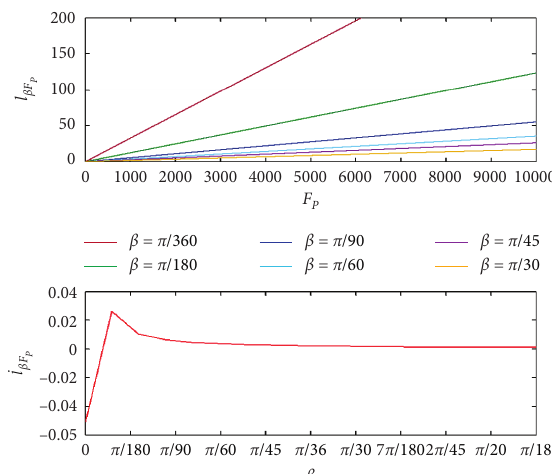
Figure 9: The relationship between the length of the gravity block l well inclination angles β and the relationship between the change rate of the gravity block length _ l